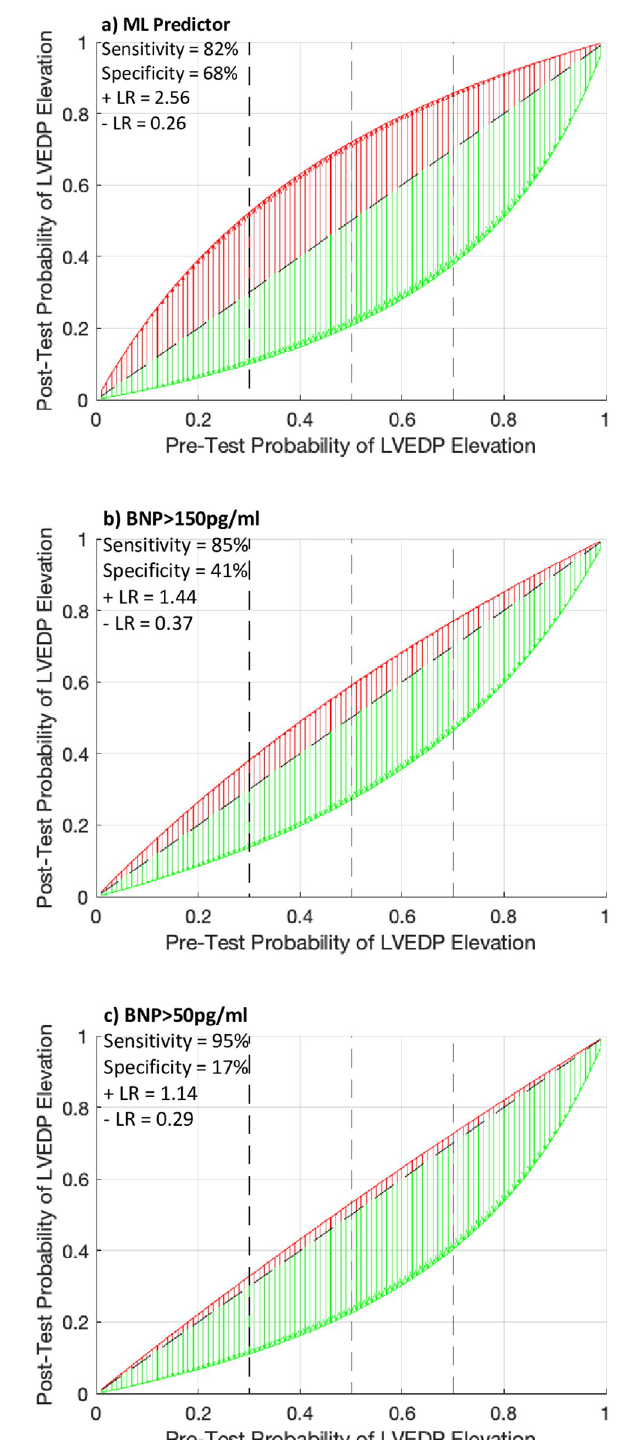
Fig 8. Relationship between pre-test (prior) probability and post-test (posterior) probabilities. a) the machine- learned predictor, b) BNP when greater than 150pg/ml, or c) BNP when greater than 50pg/ml. A positive test is shown in red, and a negative test in green. The diagonal dashed black line represents no change from the pre-test to post-test probability. The vertical dashed black lines represent intermediate to high pre-test probabilities (vertical dashed lines at 30%, 50% and 70%) from left to right. The post-test probabilities were calculated based on a varying pre-test probability, and constant sensitivity, specificity, and corresponding likelihood ratios.